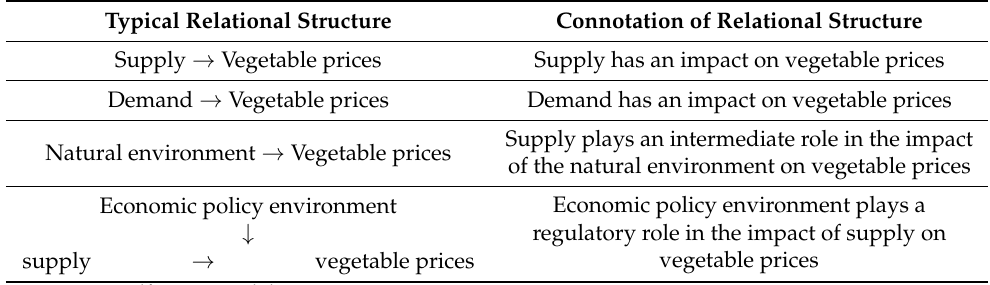
Table 5. Typical relation structure of the main